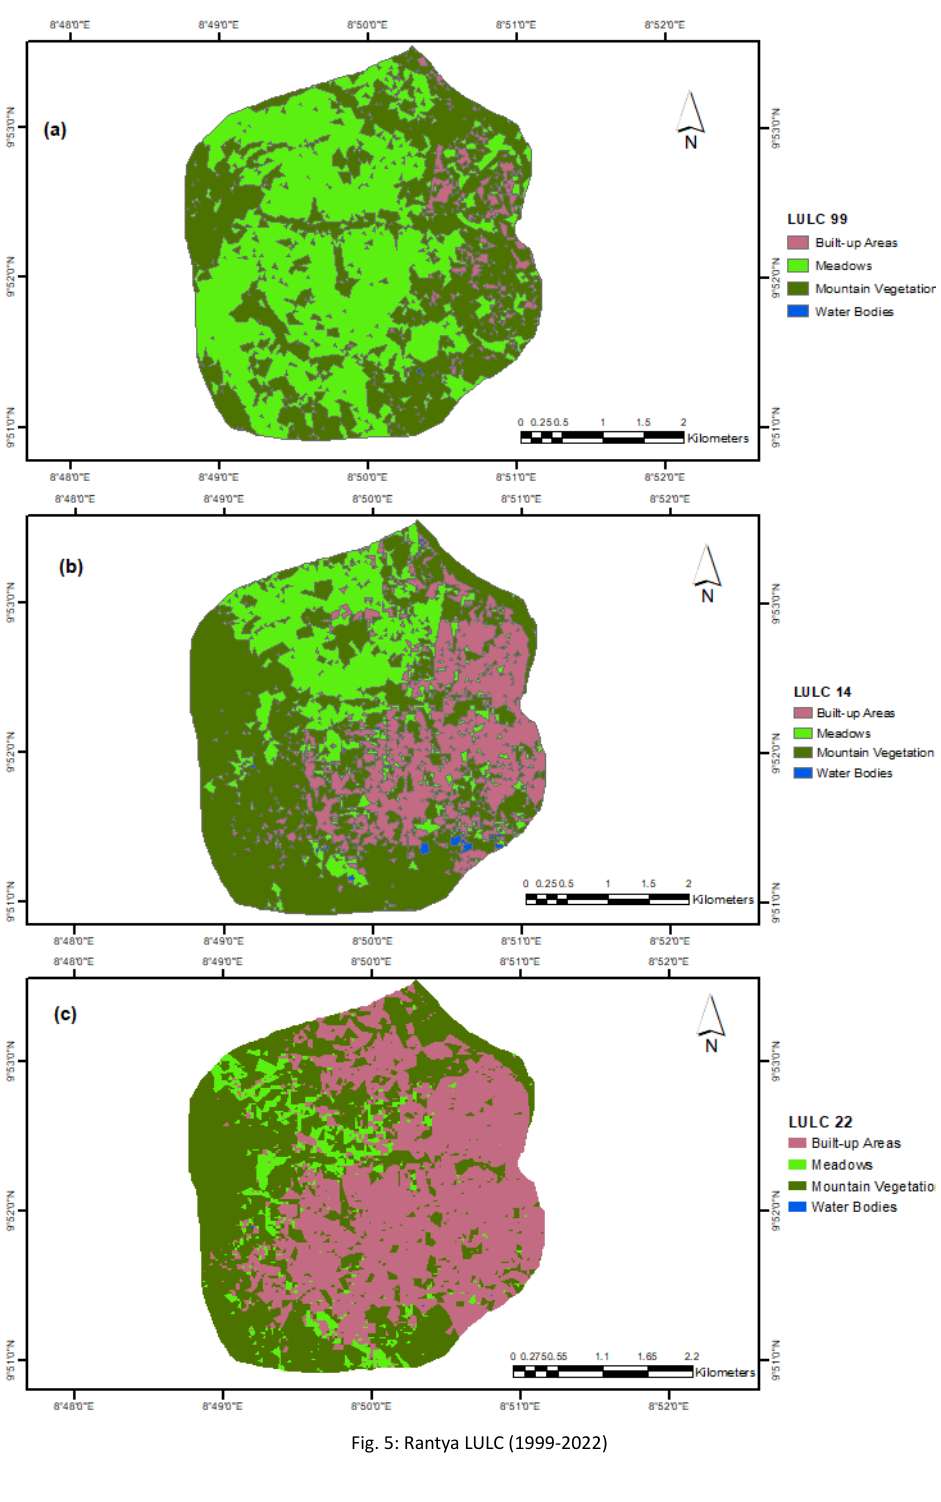
Fig. 5: Rantya LULC (1999‐2022)